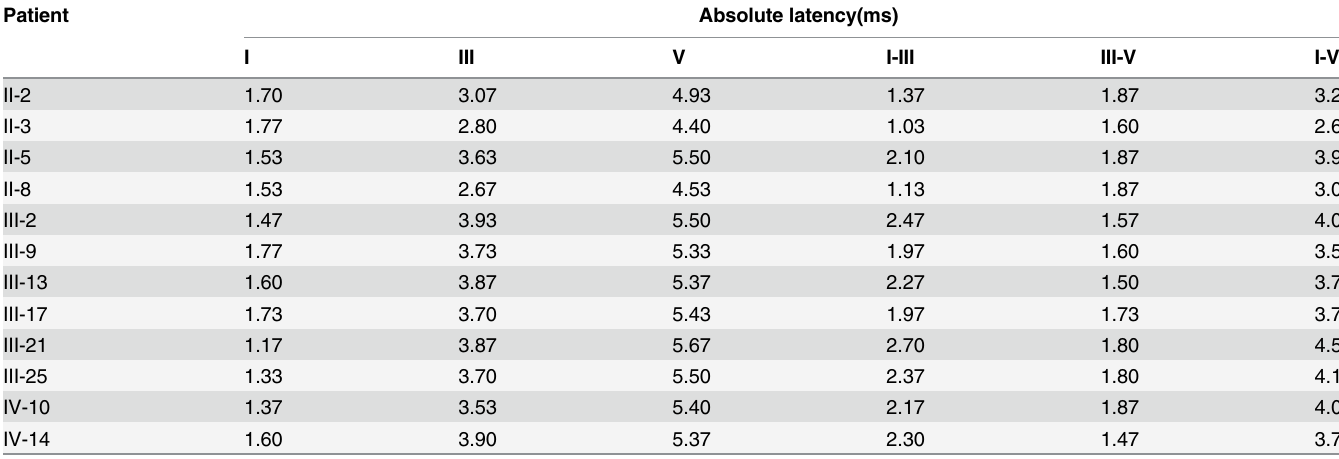
Table 1. The ABR absolute latencies of wave I, III and V and the interpeak latencies (IPLs) I – III, III – V and I – V in the right ears. Patient